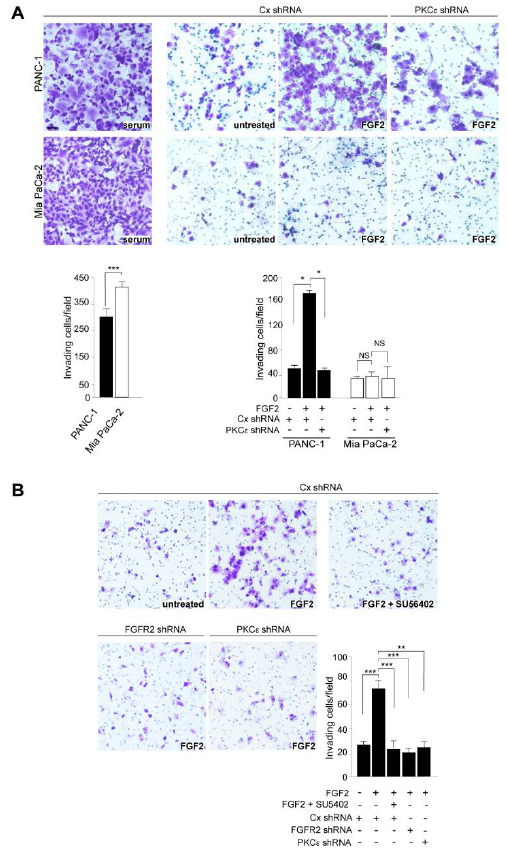
Figure 3. FGF2-induced invasive behavior of PANC-1 cells is counteracted by the interference with FGFR2c/PKC ε signaling. PANC − 1 and MIAPaCa-2 cells were transfected as described above and then seeded on Matrigel pre-coated Transwell Boyden chamber filters. Cells were then serum starved and complete medium or medium containing FGF2, in presence or not of SU5402, was added in the bottom chamber for 48 h, to stimulate cell chemotaxis. ( A ) MIAPaCa-2 cells show a higher invasive ability in complete medium, but only PANC-1 cells display an evident FGF2-specific invasive response, which is significantly dampened by PKCε depletion. ( B ) PANC-1 cells were transfected, seeded on Matrigel pre-coated chambers and stimulated with FGF2 as reported above: FGF2-induced invasion is inhibited by 3-[4-Methyl-2-(2-oxo-1,2-dihydro-indol-3-ylidenemethyl)- 1H-pyrrol-3-yl]-propionic acid (SU5402) or FGFR2 silencing, as well as by PKCε depletion. Quanti- tative analysis was assessed as reported in materials and methods. Results are expressed as the mean value of three independent experiments ± (SD). Student’s t test was performed and the significance level has been defined as p < 0.05: * p < 0.05, ** p < 0.01, *** p < 0.001. Bar: 20 µm. The evidence of a contribution of FGFR2c expression and signaling in the establish- ment of an invasive response to FGF2, encouraged us to also investigate their possible involvement in the modulation of other malignant tumorigenic features, such as the an- chorage-independent growth. To check this ability, the soft agar assay has been chosen, because it represents a reliable surrogate assay for estimating in vivo tumorigenesis.